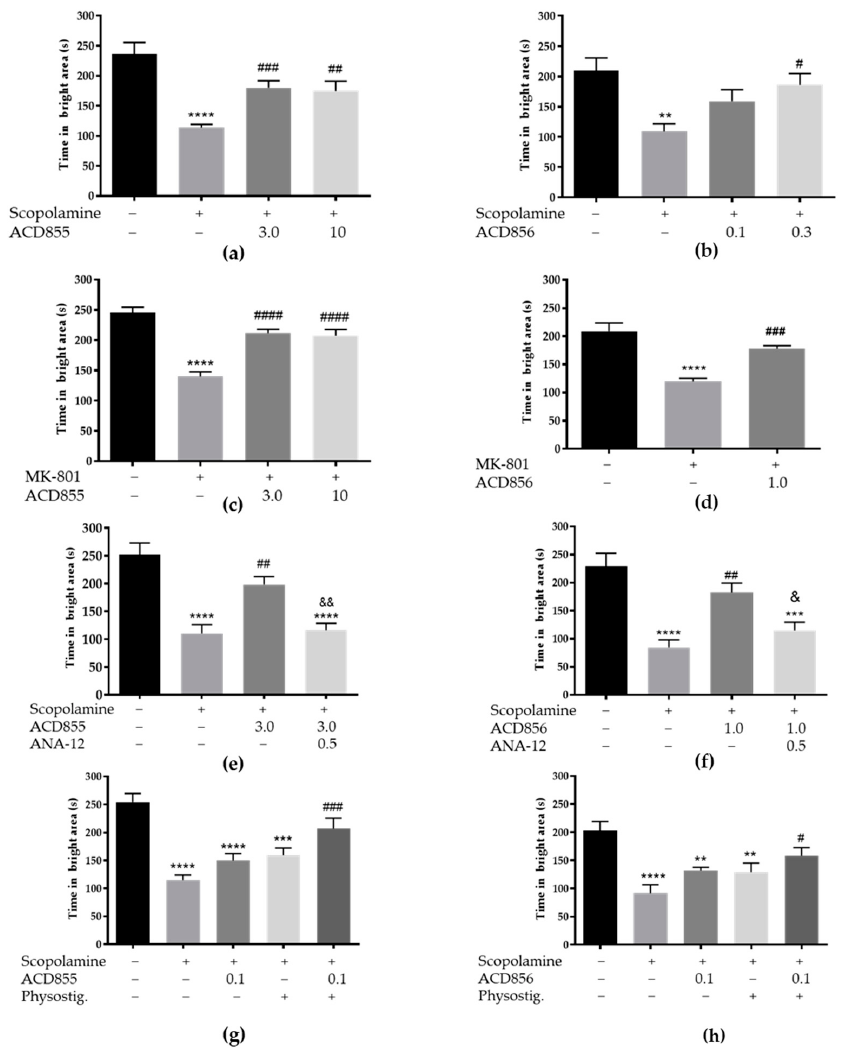
Figure 6. ACD855 or ACD856 reverses memory-impairment in the passive avoidance task in mice. ACD855 (3 or 10 mg/kg) was administered s.c. for 4 consecutive days, whereas ACD856 (0.1, 0.3 or 1 mg/kg) was administered as a single dose 60 min prior to the experiment in combination with scopolamine (0.3 mg/kg, s.c.), MK-801 (0.3 mg/kg, i.p.), ANA-12 (0.5 mg/kg, s.c), or physostigmine (0.0125 mg/kg, s.c). Memory was assessed by measuring the total time the animals spent in the bright compartment, the maximum being 300 s. ( a , b ) ACD855 or ACD856 reversed scopolamine-induced memory impairment at the indicated doses. ** p < 0.01 or **** p < 0.0001 for scopolamine vs. the control group. #### p < 0.0001, ## p < 0.01, or # p < 0.05 for compound and scopolamine-treated ani- mals vs. the scopolamine-treated group. ( c , d ) ACD855 or ACD856 reversed MK-801 induced memory impairment at the indicated doses. **** p < 0.0001 for MK-801 vs. the control group. ### p < 0.001 or ## p < 0.01 for compound- and MK-801-treated animals vs. the MK-801-treated group. ( e , f ) ANA12 inhibited ACD855- or ACD856-induced memory improvement. Animals were treated with scopolamine, ACD855 or ACD856 or ANA-12 as indicated (mg/kg). **** p < 0.001 for scopolamine vs. the control group. ## p < 0.01 for ACD855- and scopolamine-treated animals vs. the scopolamine- treated group, & p < 0.05 or && p < 0.01 for 855 and scopolamine- treated animals vs. ANA-12-, ACD855-, and scopolamine-treated group. ( g , h ) Physostigmine and ACD855 or ACD856 acted in an additive manner to reverse scopolamine-induced impairment. **** p < 0.0001 for scopolamine vs. the control group. **** p < 0.0001 or ** p < 0.01 for scopolamine + physostigmine vs. the control group.